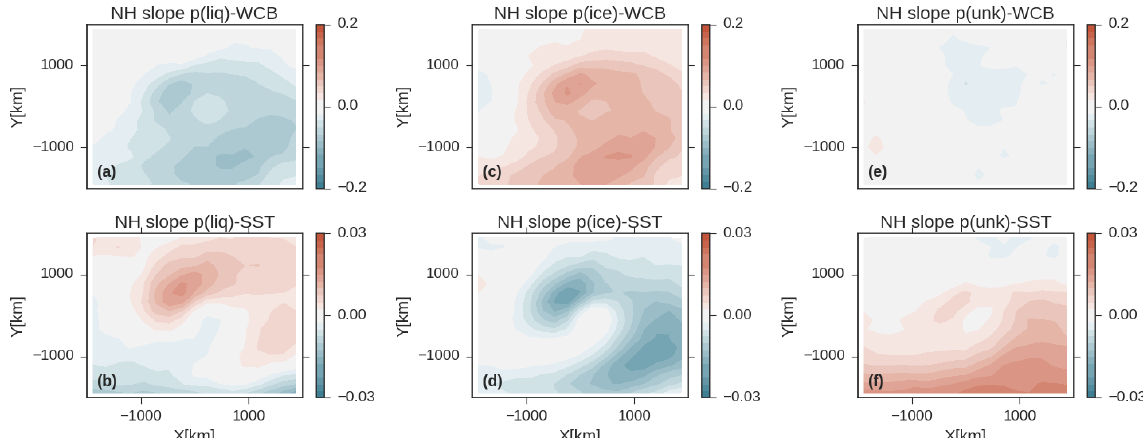
Figure 11. The coefficients in the multiple linear regression relating the probability of liquid, ice, and unknown cloud-top phase to the WCB moisture flux (units are daymm − 1 ) into the cyclone and SST ij within the cyclone (units are K − 1 , Eq. 6). All data are from the NH. Panels (a, b) relate to the probability of liquid topped clouds, panels (c, d) to ice-topped clouds, and panels (e, f) to unknown phase. Note that all probabilities are the probability of detecting a specific phase, given that a phase detection has been made. The first row shows the coefficient relating the WCB moisture flux into the cyclone to cloud-top phase probability. The second row shows the coefficient between SST ij and cloud-top phase.